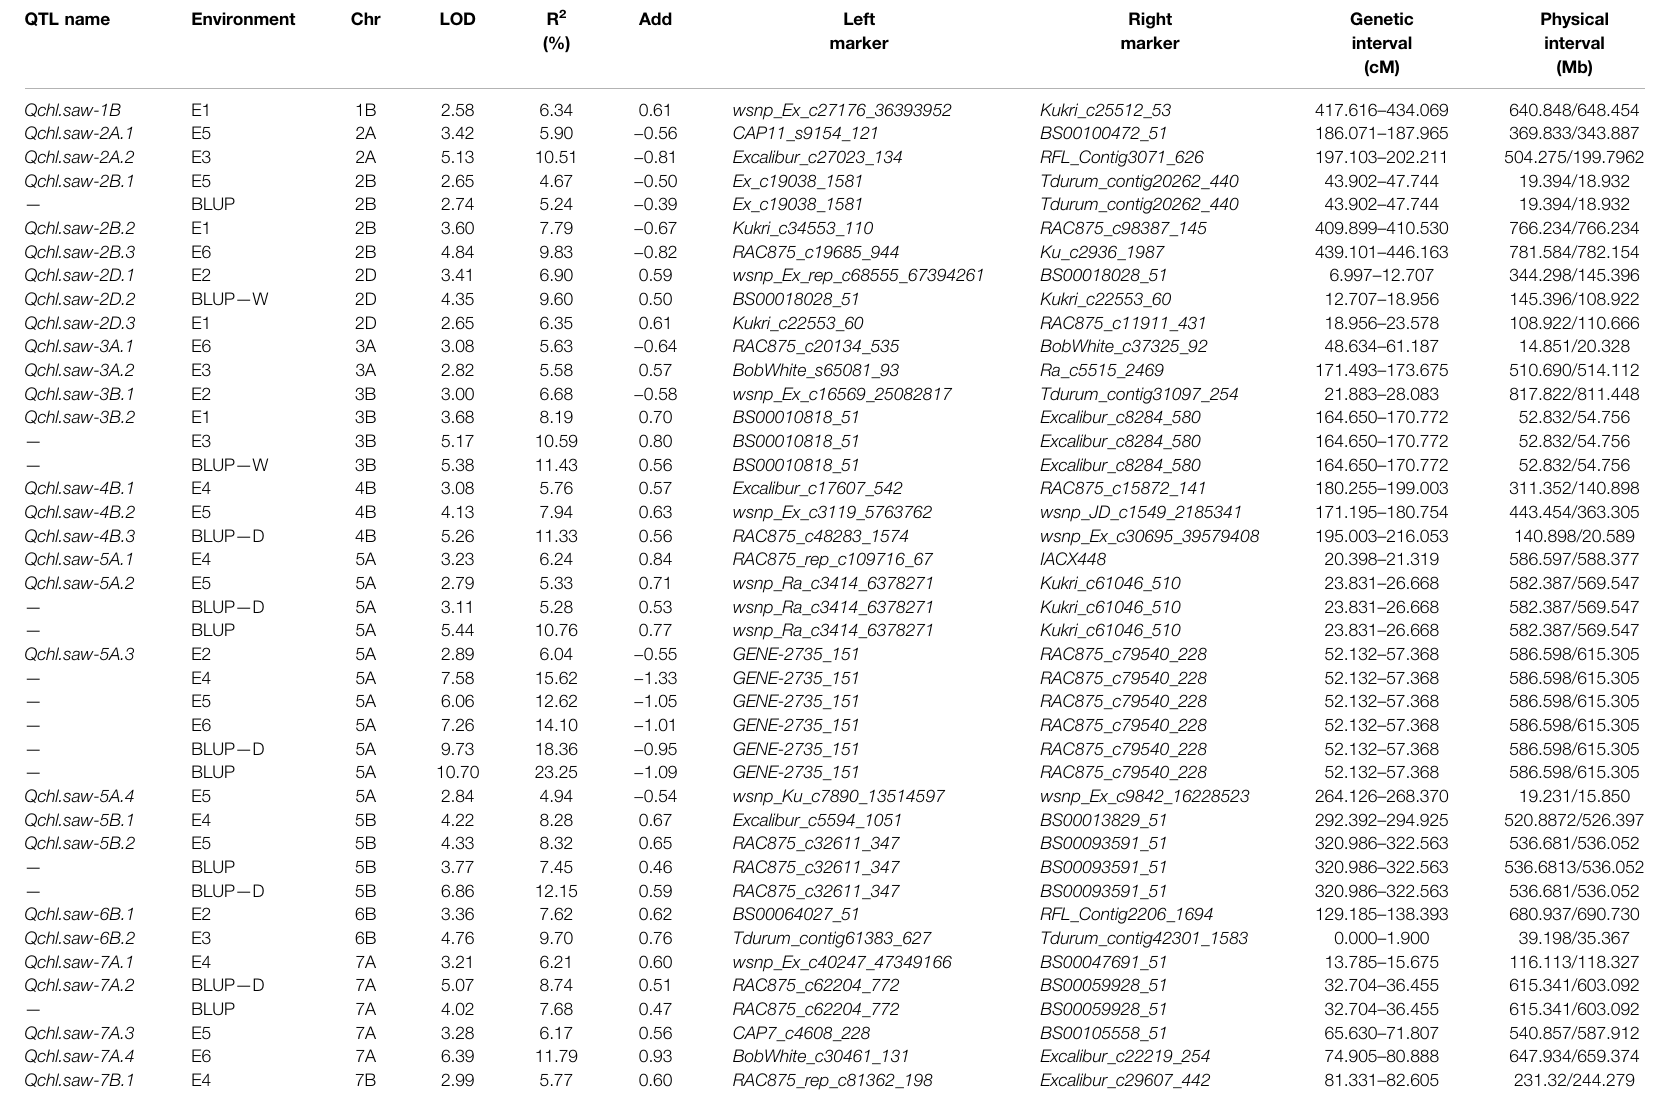
TABLE 3 | Quantitative trait loci (QTL) for chlorophyll content detected in the DH118 × Jinmai 919 RIL population grown under different water